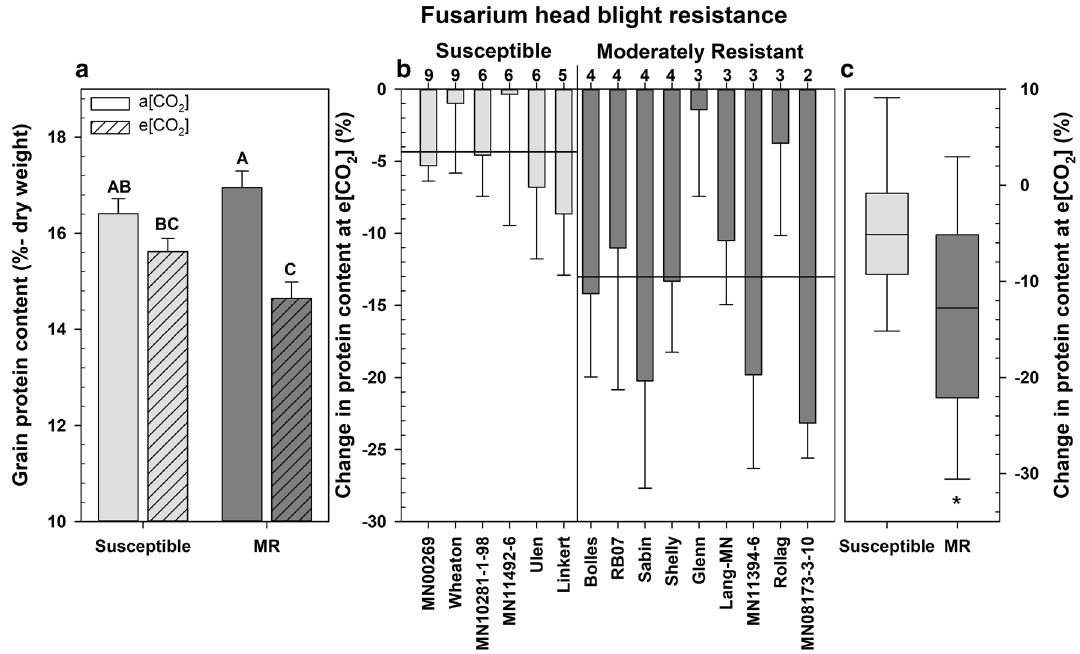
Figure 3. Percent grain protein of various Fusarium head blight (FHB) moderately resistant (MR) and susceptible wheat cultivars. Change in protein content determined by evaluating differences in grain protein from wheat grown at elevated CO 2 (e[CO 2 ]), compared with wheat grown at ambient (a[CO 2 ]). ( a ) Grain protein content of susceptible and MR wheat grain grown at a[CO 2 ] and e[CO 2 ], error bars represent standard error. ( b ) Percent change in protein content at e[CO 2 ] by cultivar and FHB resistance score. Horizonal bars represent group mean protein loss. Wheat cultivars were ordered by FHB resistance score at the top of the figure panel. ( c ) Percent change in protein content by FHB group. Different letters or asterisks (*) denote statistically significant differences as determined by a Tukey adjusted generalized mixed model analysis of variance ( P < 0.05); MR ( n = 27), and susceptible ( n = 18), for each CO 2 growth